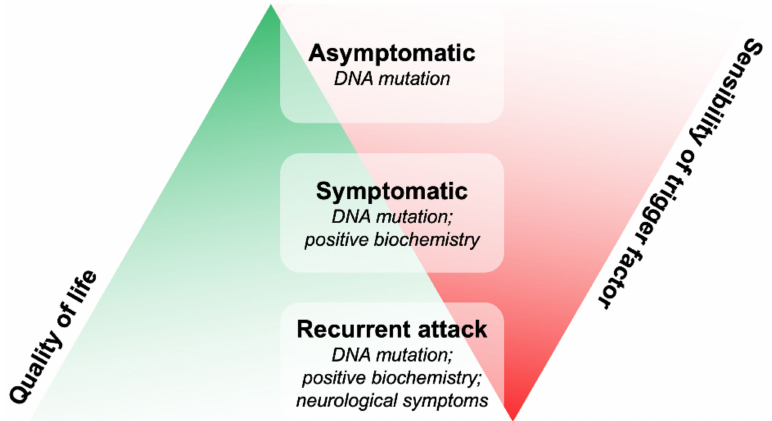
Figure 2. AHP symptoms are divided into groups of onset: (R) recurrent attack, (S) symptomatic, and (A) asymptomatic patients. The green triangle represents the patients’ quality of life, which increases at the apex. The red one represents the sensitivity to triggering factors that increase at the top of the